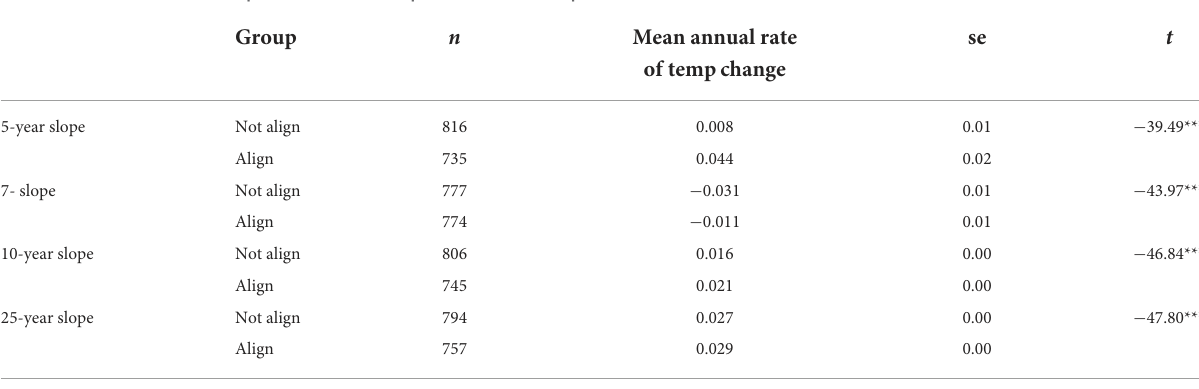
TABLE 3B Results of two-sample t -tests with unequal variances—Rainfall. Group n Mean annual rate se t of rainfall change 5-year slope Not align 655